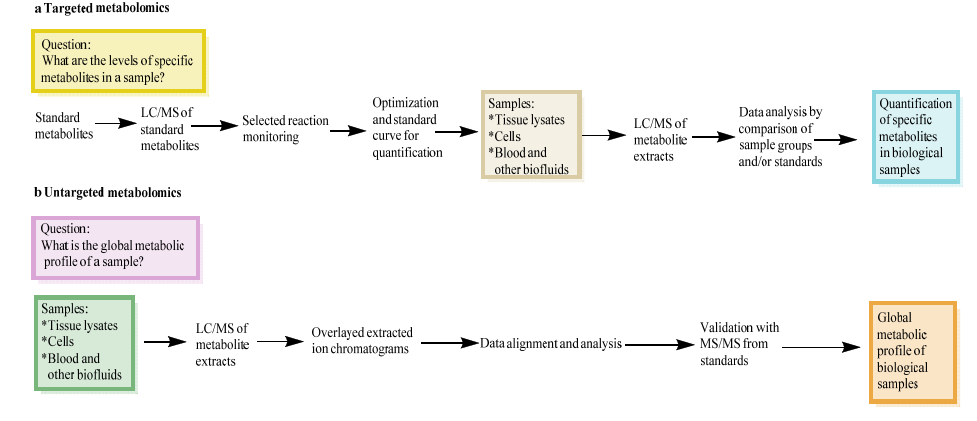
Figure 10. The targeted and untargeted workflow for LC/MS-based metabolomics [129].